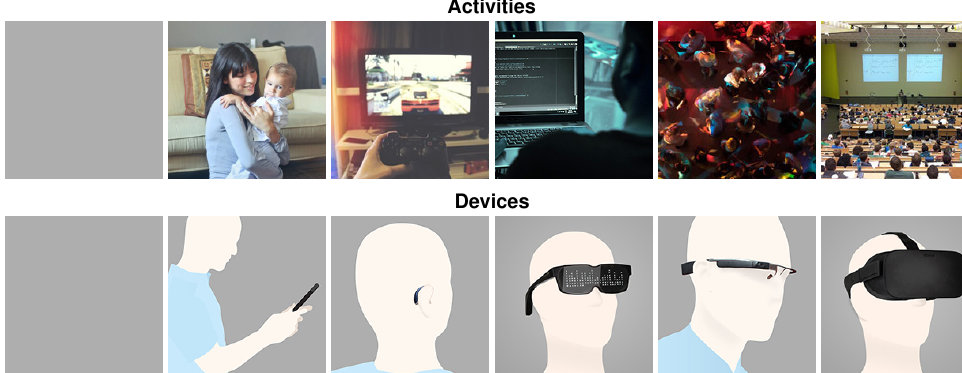
Figure 4. First row shows the images of the different activities presented in our study: any activity , babysitting , gaming , hacking , partying , and teaching (Images source: https://pxhere.com/ (accessed on 19 September 2022), licensed under public domain). Second row shows illustrations of the used devices: any device , e-readers , hearing aids , LED glasses , smart glasses , and VR headsets (image sources: